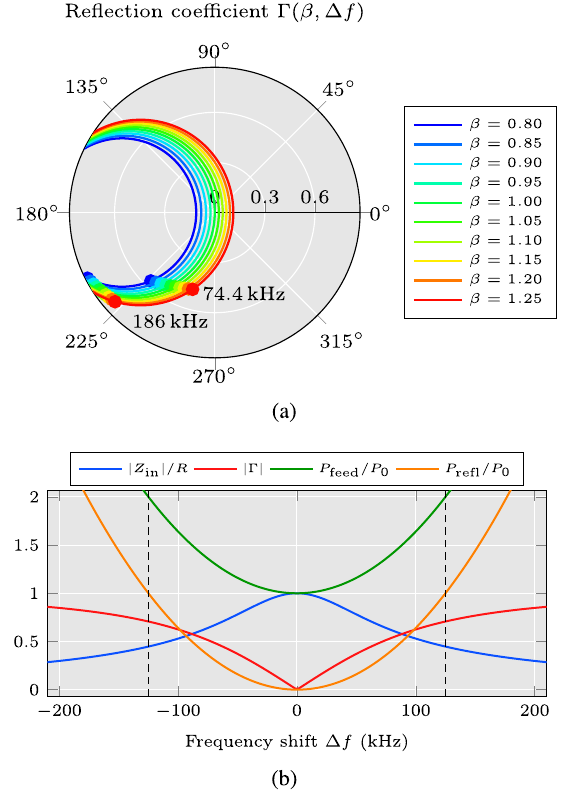
FIG. 10. A polar chart of the reflection coefficient depending on rf source frequency offset and coupling coefficient β is shown in (a). The points mark frequency shifts corresponding to a heat- induced deformation at operation with 1% and 2.5% duty cycle, respectively. For the case of β ¼ 1 critical coupling, the input impedance, reflection coefficient, and powers are shown in (b) as functions of the frequency; the dashed lines mark the 3 dB bandwidth.